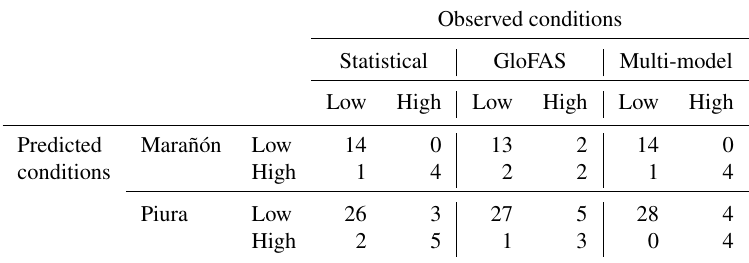
Table 4. Contingency table for statistical, GloFAS, and multi-model predictions of high-flow (top 20%) and low-flow (bottom 80%) MAM (FMA) streamflow for the Marañón (Piura) River.